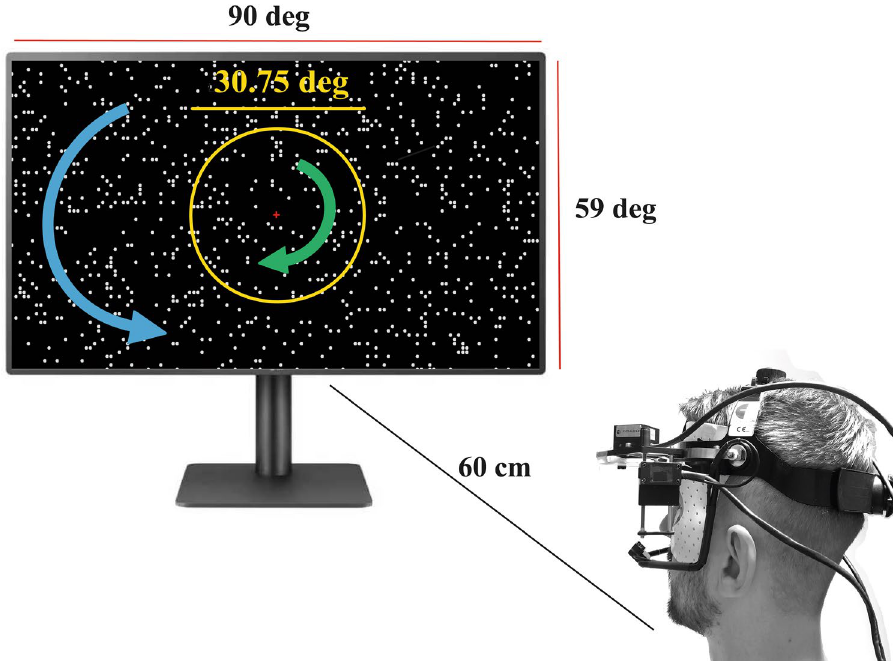
Figure 1. An illustration of the visual scene (left) as viewed by a participant wearing the Chronos Eye Tracker at an eye-screen distance of 60 cm (right). The visual scene was divided into a central area (yellow circle) and a peripheral area that was delineated by the edges of the monitor (red lines). The central area encompassed a diameter of 30.75° of the participant’s visual field, while the peripheral area extending 90° horizontally and 59° vertically. The motion pattern outlined in this example represents a non-coherent stimulation consisting of clockwise central motion and counter-clockwise peripheral motion. The central red cross acted as the fixation point on which participants were asked to fix their gaze, while maintaining the chin on a chinrest, for the duration of the stimulation